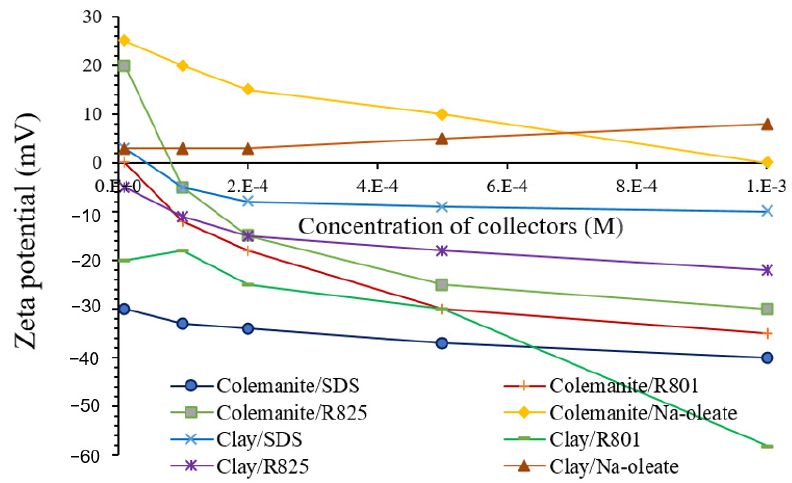
Figure 4. Effect of reagent concentration on the zeta potential of colemanite and its associated clayey